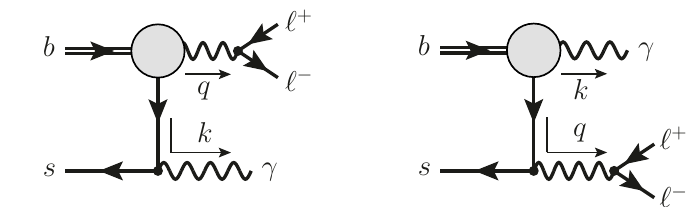
Figure 2 . The LP A -type and B -type insertions. The grey blob denotes the effective hard vertex of the operators P 1 ,..., 8